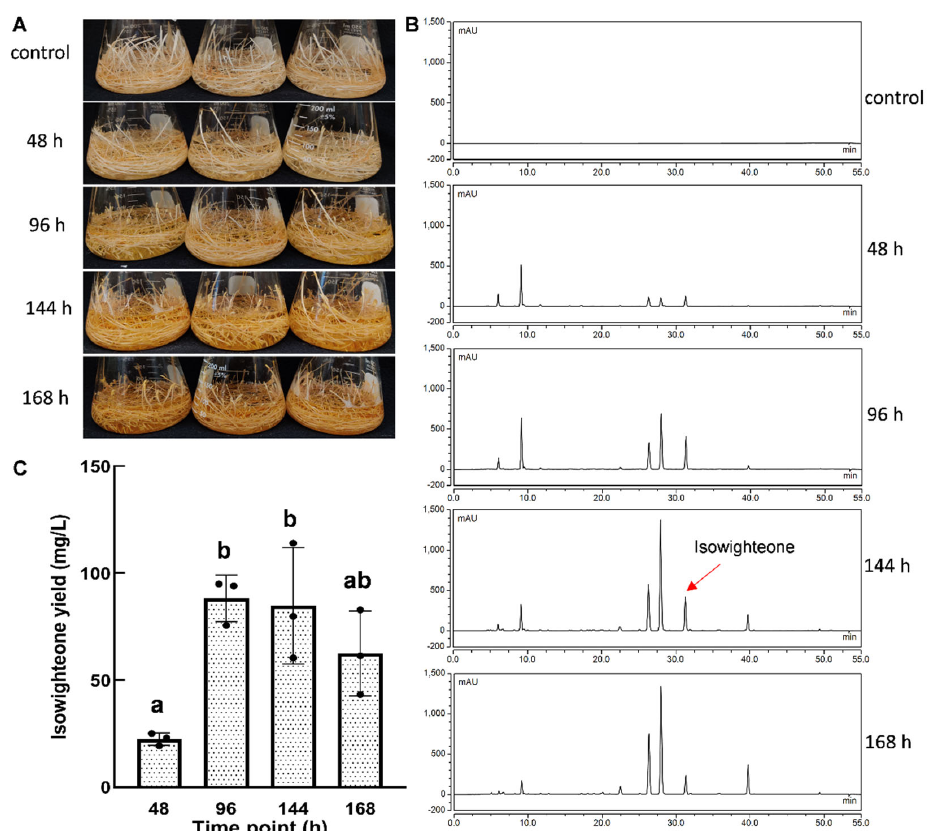
Figure 5. Time course of isowighteone yield in the elicited culture medium of 12-day-old pigeon pea hairy root cultures. ( A ) Change in phenotype after elicitor treatment. ( B ) HPLC chromatogram of culture medium extract after elicitor treatment for different time points. All chromatograms were monitored at 260 nm. ( C ) Comparison of isowighteone yield in the culture medium of hairy root cultures elicited for different time points. Yields are expressed in mg/L. Each bar represents the average of three biological replicates. Error bar represents standard deviation. Statistical analysis was performed using one-way ANOVA with Tukey’s multiple comparisons test. The lower-case letters above the column represent significant (between different letters) or non ‐ significant (between the same letter) statistical differences. (Significance level between a and b, p < 0.05). Table 2. Yield of isowighteone in the hairy root culture of pigeon pea (line G4). Twelve ‐ day ‐ old cultures were co ‐ treated with methyl jasmonate, methyl ‐β‐ cyclodextrin, hydrogen peroxide, and magnesium chloride.